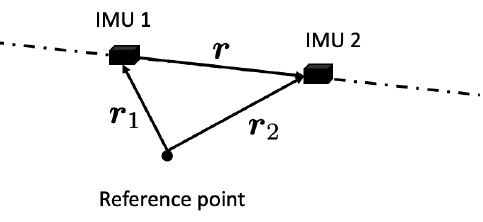
Figure 2. Illustration for angular acceleration using two